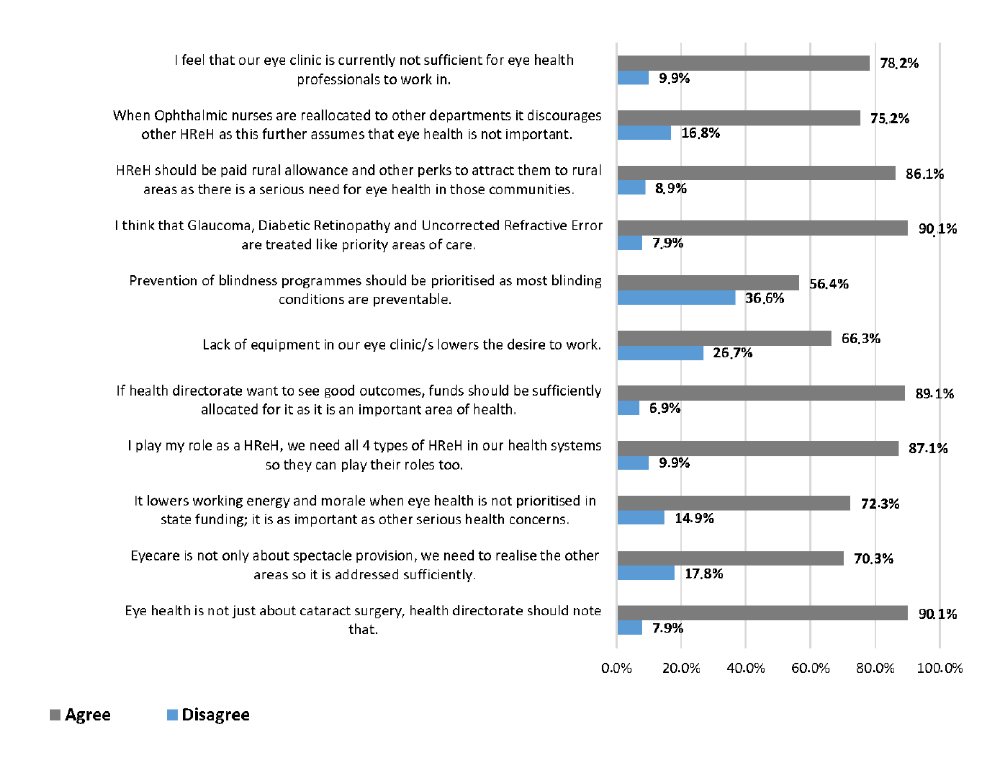
Figure 1. Summary of responses related to attitude towards eye